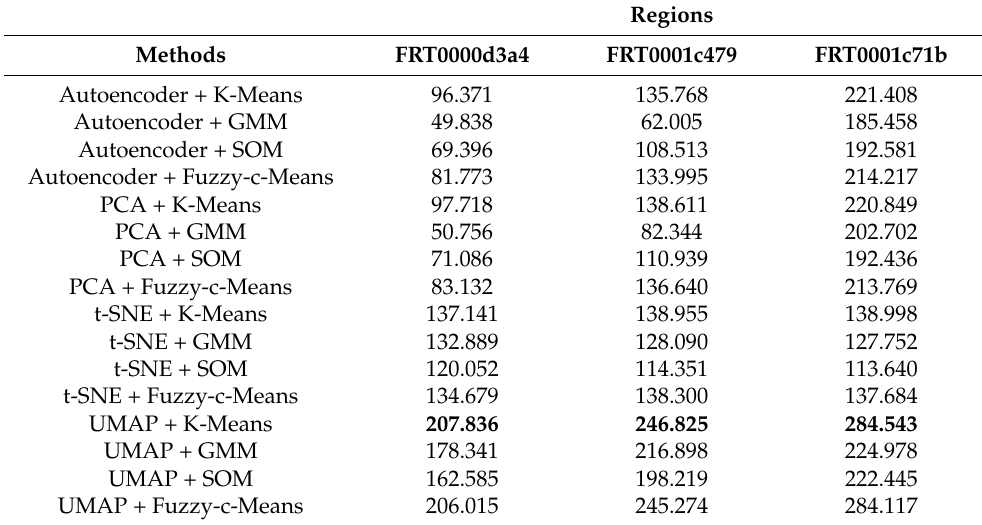
Table 1. Mean of the Calinski–Harabasz criterion over a range of 3 to 7 clusters, split by method and region. The best score for each dataset is in